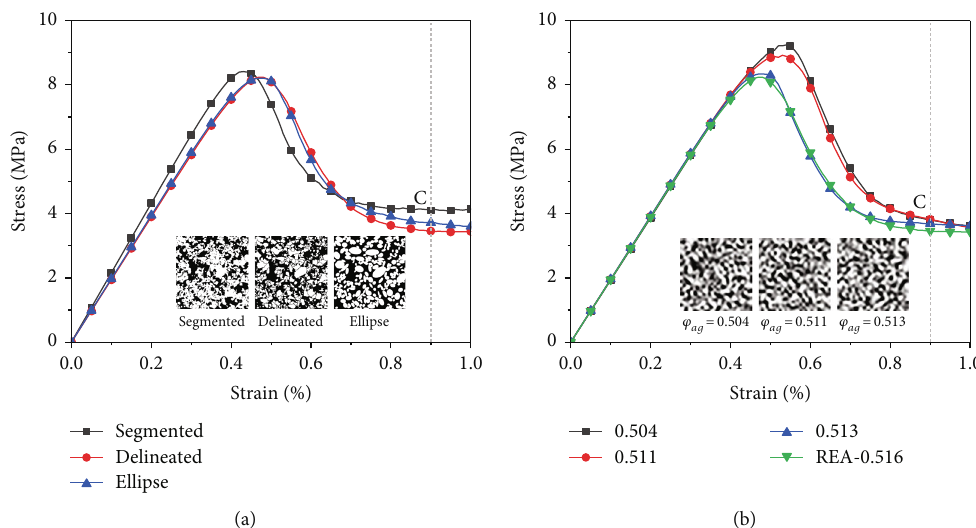
Figure 6: Stress – strain relationships of the (a) simpli fi ed S3-mREAs and (b) random models under loading in the y -axis direction.